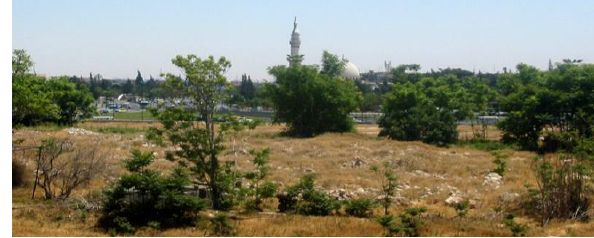
Figure 3. The Sukkar garden, R.Aboukhater, May